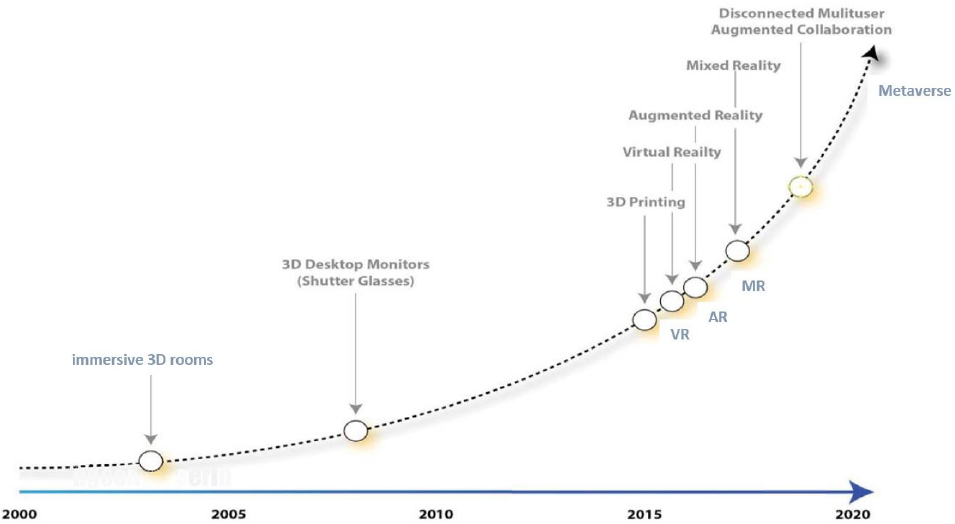
Figure 1. Technical evolution of Understanding and Visualization in the last 20 years, modified from [18].